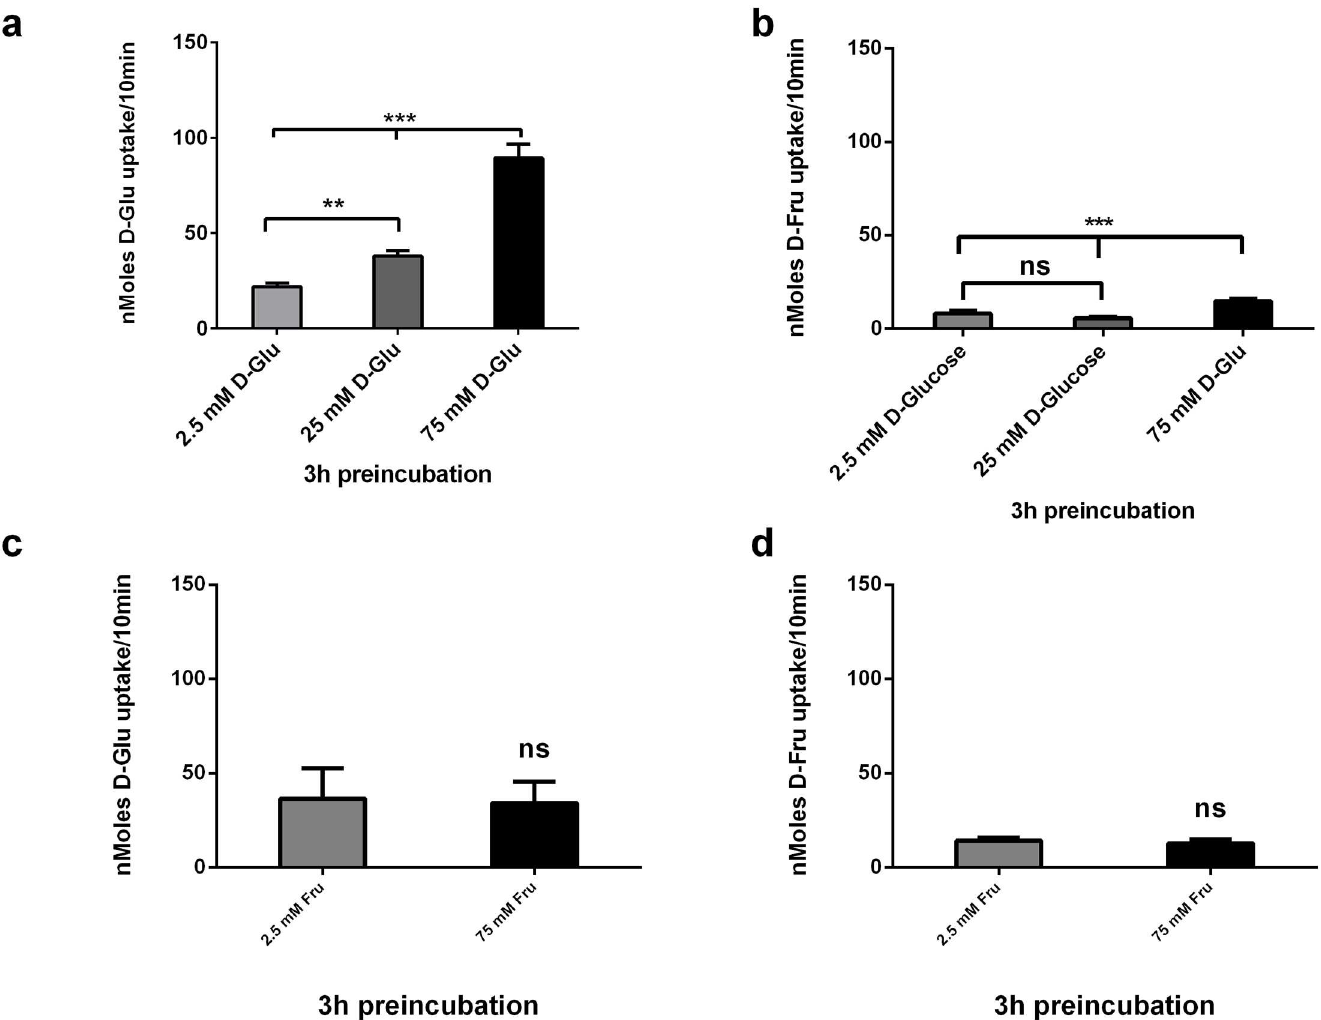
Fig 3. Acute effectsof D-Glucose and D-Fructose on carriermediated [ 14 C] 10 mM D-Glucose and D-Fructose uptake into Caco-2/TC7 cells. Caco-2/TC7 cells grown for 21 days were incubatedwith 2.5, 25 and 75 mM D-Glucoseor D-Fructose for 3hrs, washedin sugar free KBS, followedby 10 mins exposureto (a and c) [ 14 C] 10 mM D-Glucoseand (b and d) [ 14 C] 10 mM D-Fructose. Cellularuptake of D-Glucoseand D-Fructose was measured by radioactivescintillation spectrometry. Osmolarity was adjustedby addingMannitol.Uptake is corrected for simple diffusion of 10 mM [ 14 C] L-Glucose. Data are expressedas nMoles D-Glucoseor D-Fructose uptake/well/10min ± SD of n = 4 per condition. * P < 0.05, ** P < 0.01, *** P < 0.001, ns = not